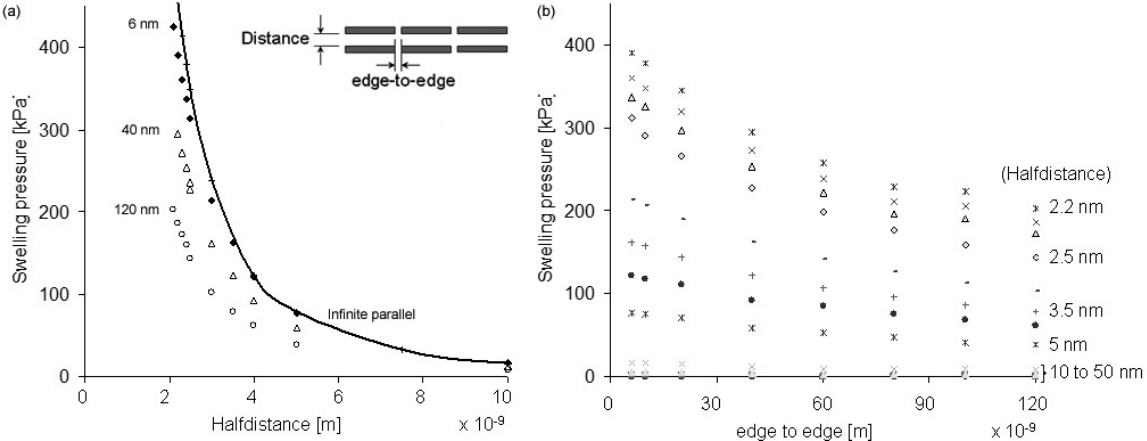
Fig. 5 – Swelling pressure in stacked parallel platelets fabrics ( c 1 mol ∙ m − 3 σ = − 0 . 266 C ∙ m − 2 ) : (a) as a function ∞ = of half-distance between platelets for edge-to-edge distances of 120, 40, 6 and 0 nm (infinitely long parallel platelets); (b) as a function of edge-to-edge separation for 2.2, 2.3, 2.4, 2.5, 3, 3.5, 4, 5, and 10 through 50 nm